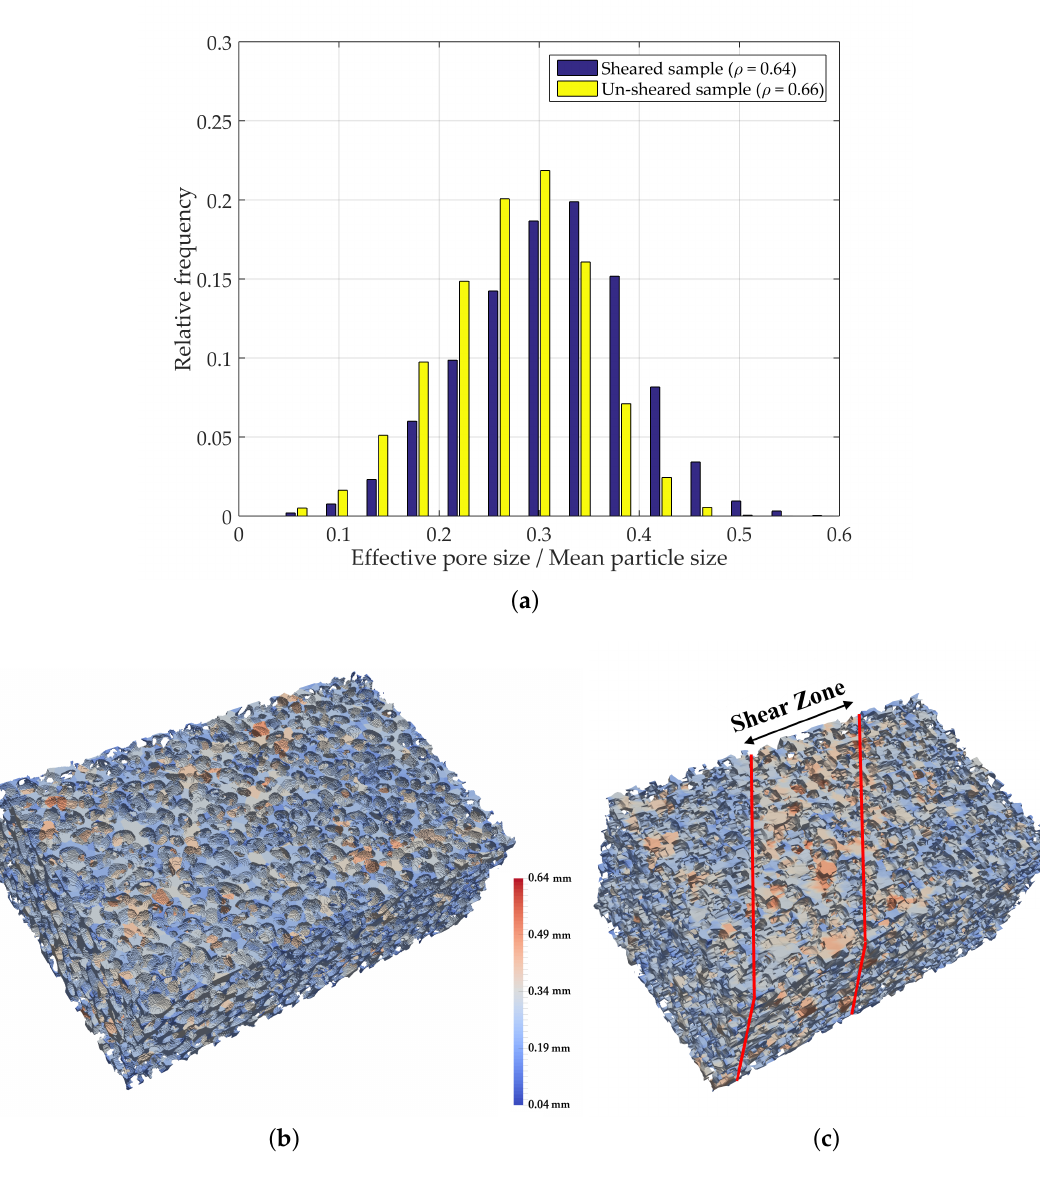
Figure 17. Pore segmentation visualization and PSD for reconstructed un-sheared and sheared Ottawa 20–30 sand. ( a ) PSD for reconstructed un-sheared sample; ( b ) segmented pores for reconstructed un-sheared sample; ( c ) segmented pores for reconstructed sheared